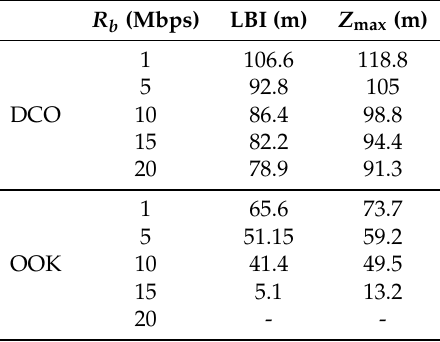
Figure 5. BER comparison of OOK and 4-QAM DCO-OFDM for P Tx,e = 125mW. N = 1024. N CP = 2, 3, 5, 7, and 9, for R b = 1, 5, 10, 15, and 20Mbps, respectively. Table 2. LBI and maximum attainable range for OOK and 4-QAM DCO-OFDM transmission schemes according to Figure5; P Tx,e = 125mW, BER = 10 − 3